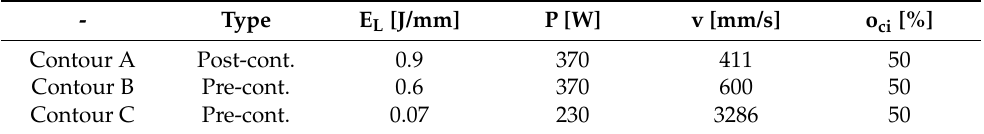
Table 3. In-process contour parameter sets with different line energy E L , laser power P, scan speed v, and percentage overlap of the contour scan with the infill o ci used in this study [44]. -